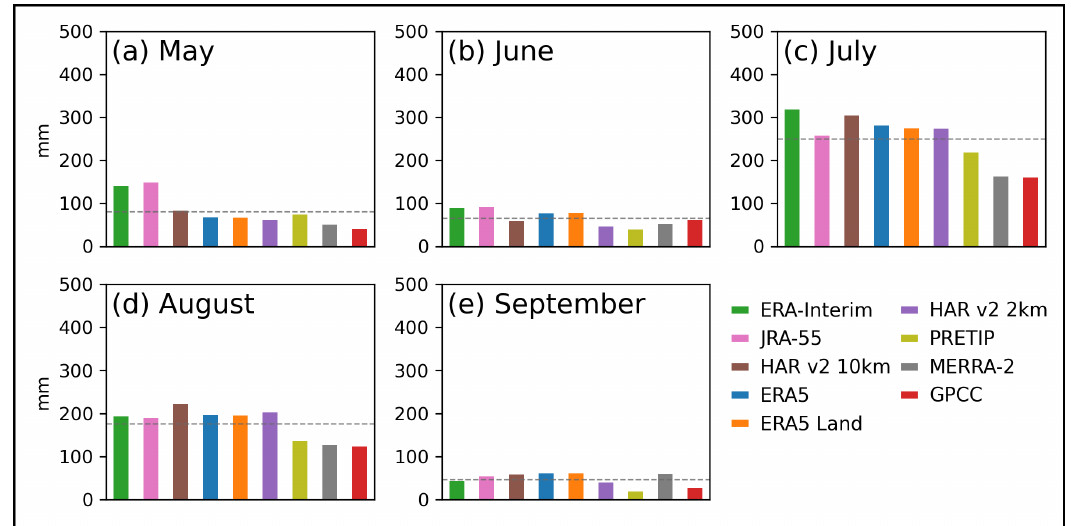
Figure 4. Spatial average monthly sum of precipitation during the study period. The gray dashed line represents the mean precipitation in each month over all datasets.